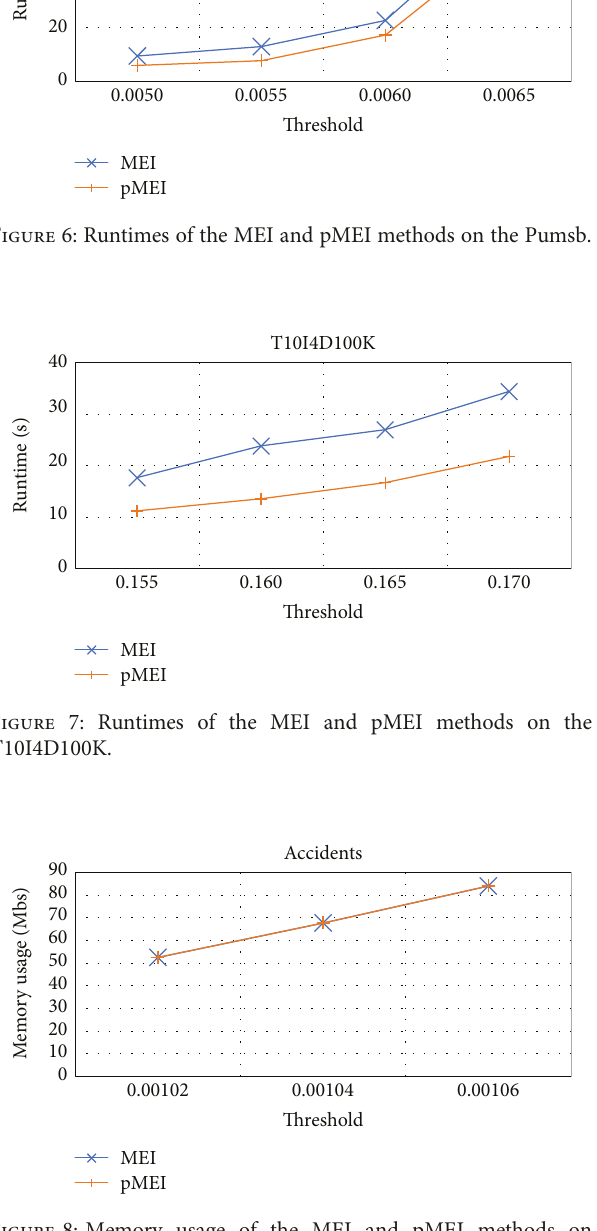
Figure 8: Memory usage of the MEI and pMEI methods on the